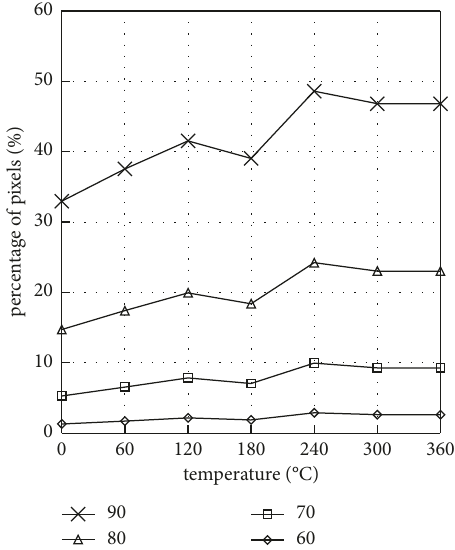
Figure 3: The line graph of coking coal sample pixel percent to different pixel